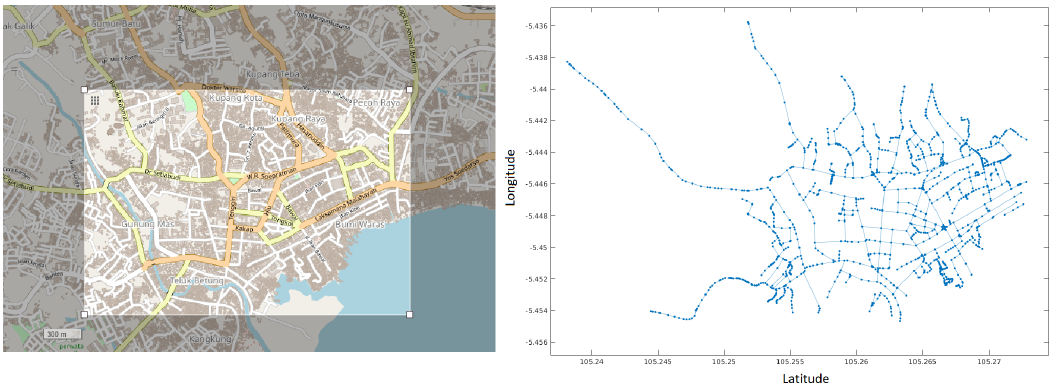
Figure 3. Left: captured region of Bandar Lampung map. Right: graph model of the